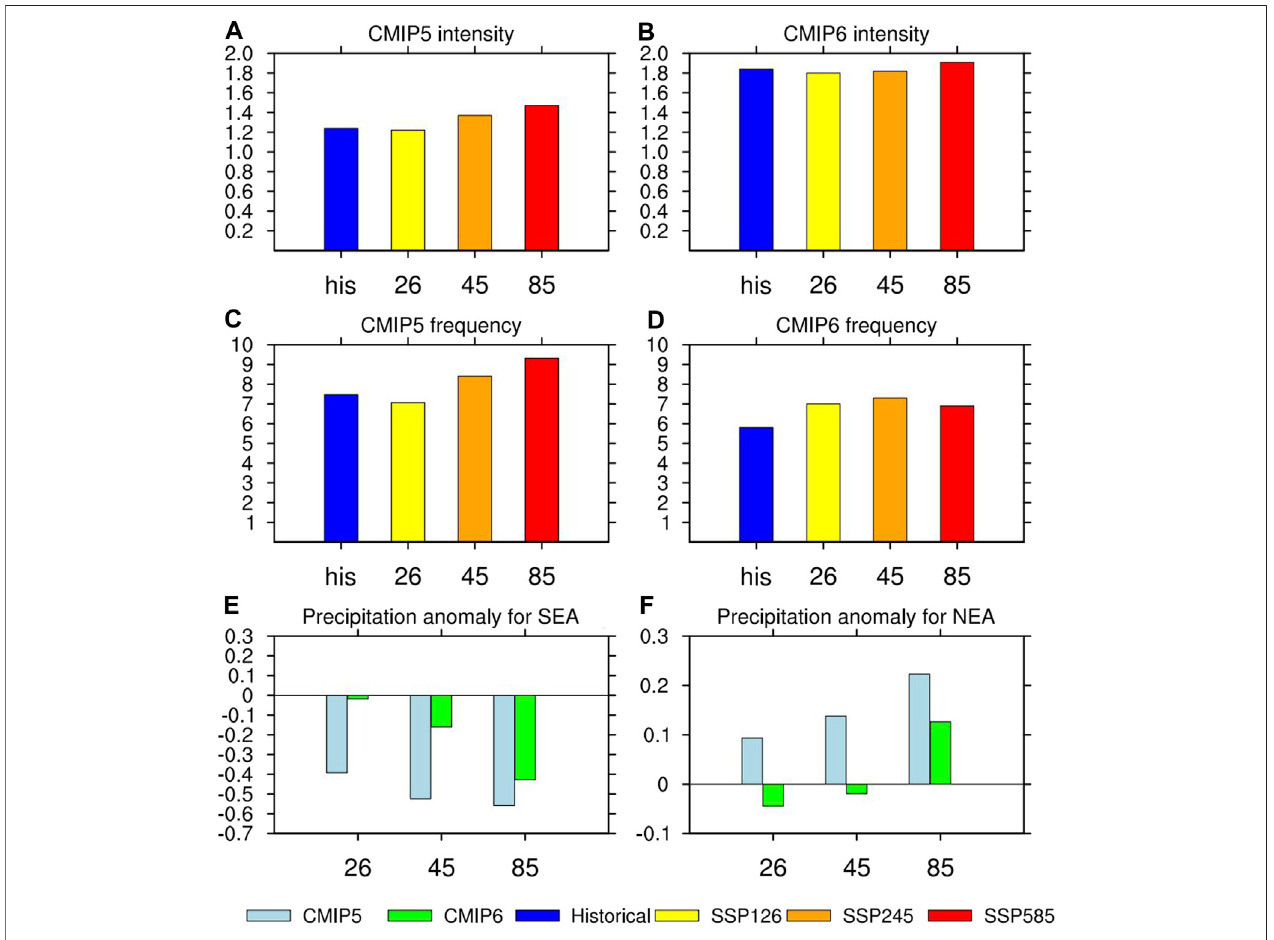
FIGURE 4 | The changes of the intensities (A,B) and frequencies (C,D) for strong EP events, and the precipitation anomalies over southern East Asia (22 – 26 ° N, 115 – 120 ° E) and northern East Asia (28 – 32 ° N, 112 – 120 ° E) (E,F) responding to the different emission scenarios in CMIP5 and CMIP6.